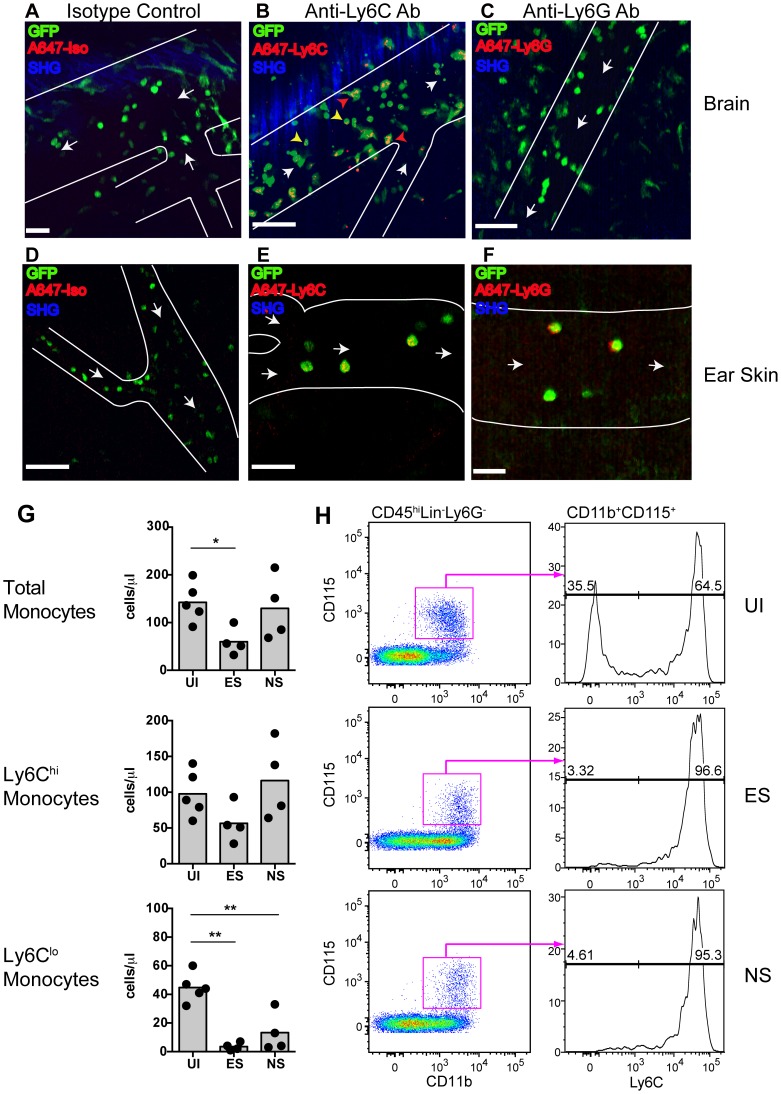
Endothelium-interacting GFP+ leukocytes in the brain microvasculature are monocytes.PbA-infected MacGreen mice with NS were injected i.v. with 5 µg of either (A) an isotype control, (B) anti-Ly6C (n = 2) or (C) anti-Ly6G antibody (n = 2) 1 hour prior to mice undergoing intravital imaging of the brain microvasculature. Representative snapshots from each group are shown. Scale bars represent 30 µm in (A), 100 µm in (B) and 58 µm in (C). Blue represents SHG signals from extracellular matrix fibres. White arrows indicate direction of blood flow. To aid orientation, vascular walls are outlined. Cells stained with Ly6C antibody show an orange punctate stain that co-localises with GFP (red arrowheads = adherent cells; yellow arrowheads = rolling cells). A total of 37, 29 and 45 blood vessels were assessed for the isotype control, Ly6C and Ly6G groups respectively. Number of blood vessels per mouse: Isotype (n = 37), Ly6C (n = 14, 15) and Ly6G (n = 9, 36). Representative snapshots of intravital imaging of the dermis of Lysozyme-GFP mice after injecting 5 µg of (D) an isotype control, (E) anti-Ly6C or (F) anti-Ly6G antibody, as reported [34]. Number of blood vessels per mouse: Isotype (n = 12), Ly6C (n = 11) and Ly6G (n = 11). Cells stained with Ly6C show a punctate stain as in the brain. Cells stained with Ly6G have a red surface stain. Scale bars represent 60 µm in (D), 30 µm in (E) and 20 µm in (F). (G) Changes in blood monocyte populations during ECM. Blood monocytes were quantified by flow cytometry after collection from either uninfected (UI) or PbA-infected mice that had developed ES or NS (n = 4–5 mice/group). Symbols represent individual animals and bars represent means. *P<0.05, **p<0.01 (ANOVA with Dunnett's post-test vs. UI control). (H) Representative flow cytometric plots showing blood monocyte populations in UI, ES and NS mice. The percentage of Ly6Clo and Ly6Chi monocytes are indicated. Data are from a single experiment (n = 4–5 mice/group).